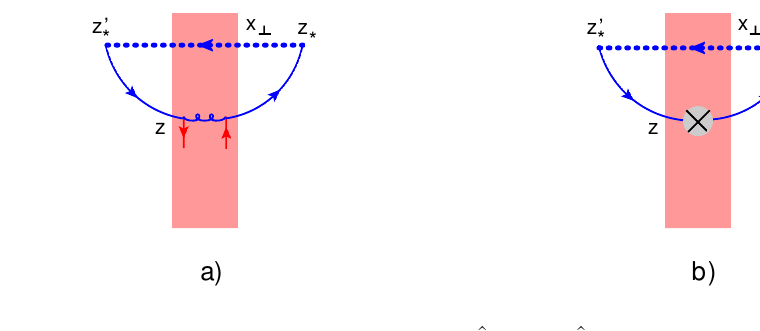
Figure 5 . Diagrams with ˆ Q